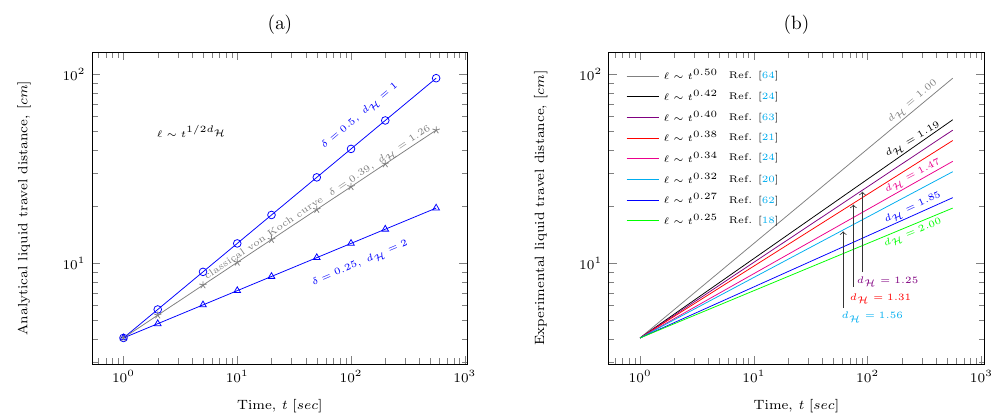
Figure 3. Time scaling δ = 1/2 d H of the capillary rise in the first stage of imbibition on generalized von Koch curve. ( a ) Fluctuations of time scaling exponent 0.25 ≤ δ ≤ 0.5 depend on the Hausdorff dimension of medium, and ( b ) Experimental results on capillary imbibition in porous media, where δ = 1/2 d H holds, see Refs.